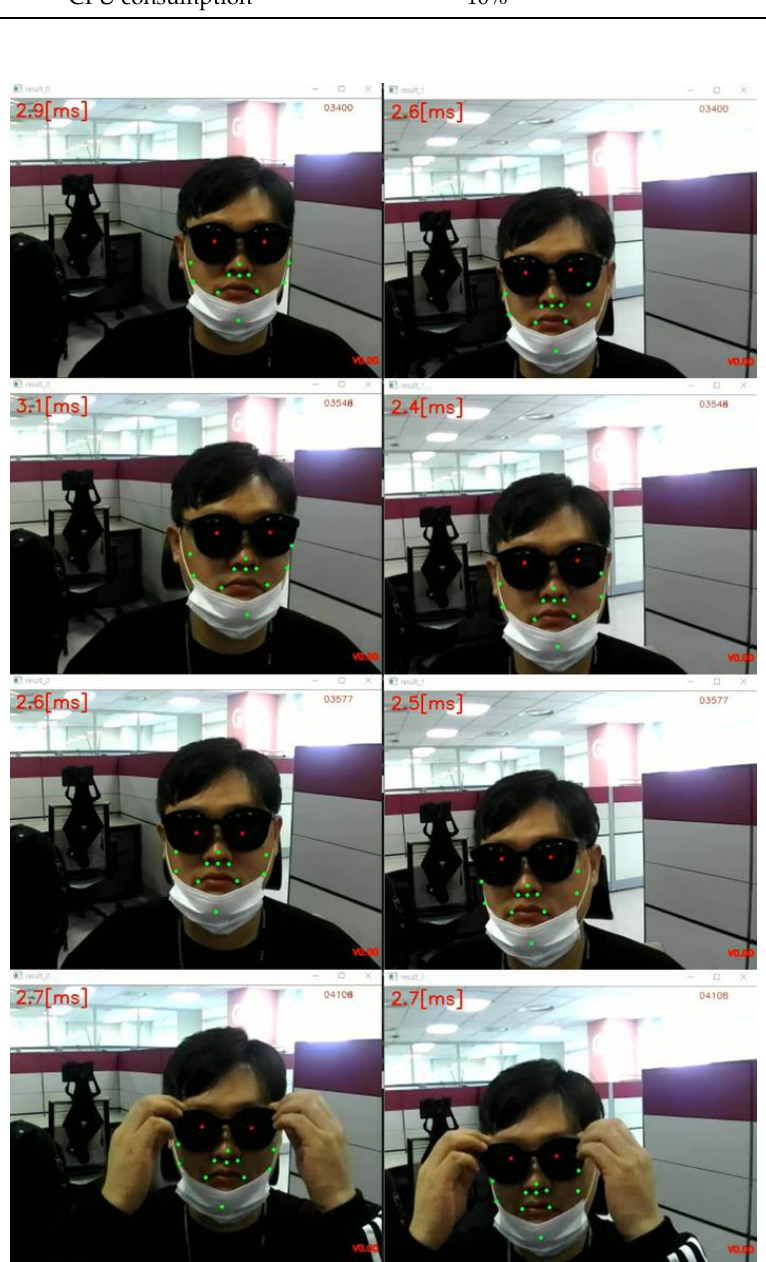
Figure 6. Seamless eye tracking for a user wearing sunglasses. A stereo RGB camera was used for 3D position conversion. The two columns show the left and right images from the stereo camera.